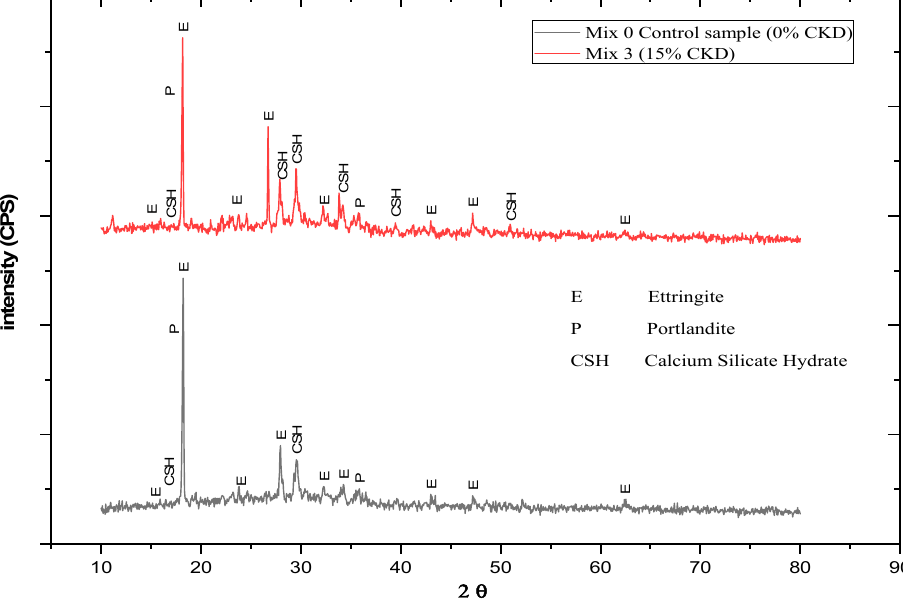
Figure 12. Qualitative XRD patterns of the 28-day cured samples from Mix 0 and Mix